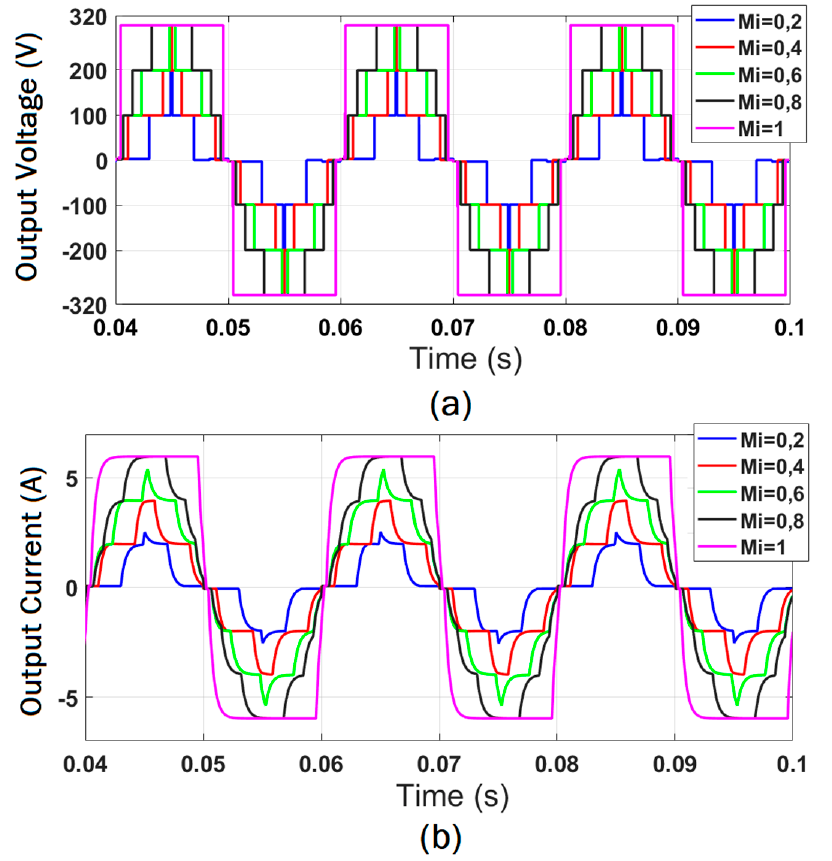
Figure 8. The output currents and voltages depend on the modulation index for a 7-level MLI inverter using a BMO.